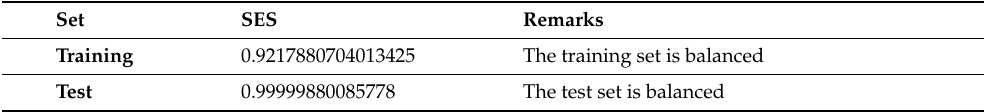
Table 2. SES results for the traffic sign